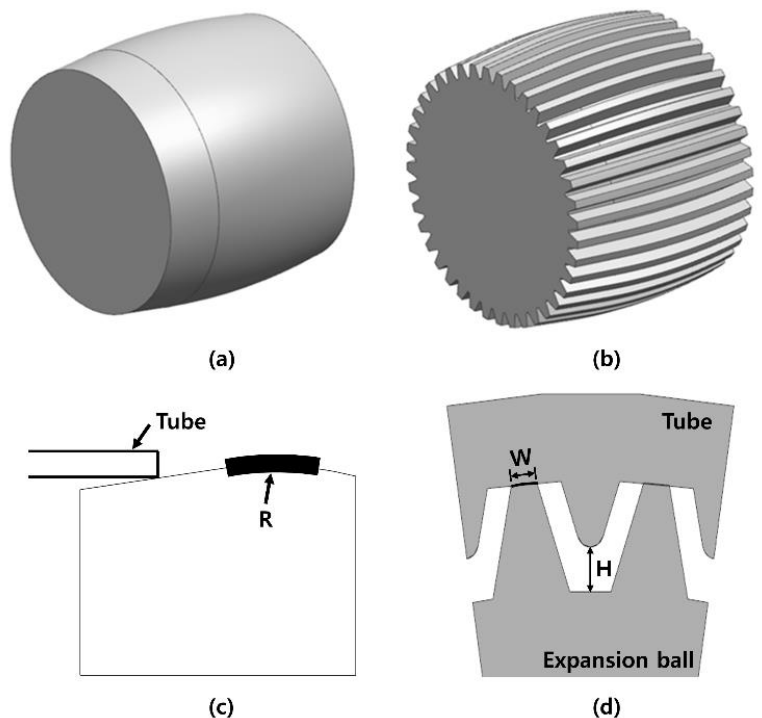
Figure 4. ( a ) Three-dimensional models of a smooth expansion ball (Type 1); ( b ) an expansion ball with expansion grooves on its surface for distributing concentrated load on the tube’s inner grooves during the tube expansion (Types 2–5); ( c ) schematic of expansion balls with the radius of curvature R as the design variable (Types 6 and 7); and ( d ) definitions of width ( W ) of the expansion ball groove and gap ( H ) between the valley of the expansion ball groove and the peak of the tube’s inner groove